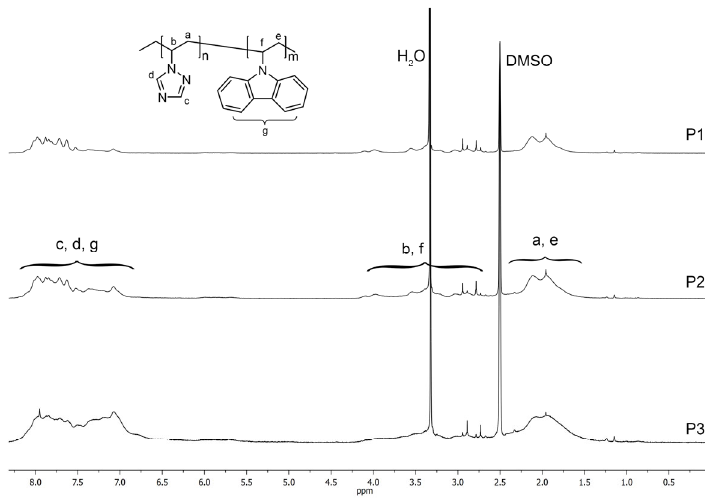
Figure 4. 1 H NMR spectra of P1–P3 poly(VT- co -VK) copolymers.